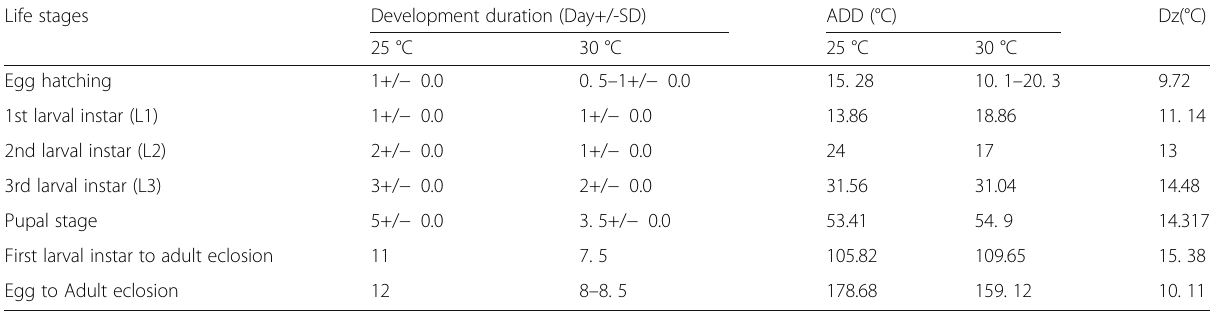
Table 1 Development duration and thermal requirements (ADD) of Chrysomya albiceps (second generation) at constant temperatures (RH = 50%, Photoperiod = 14: 10)